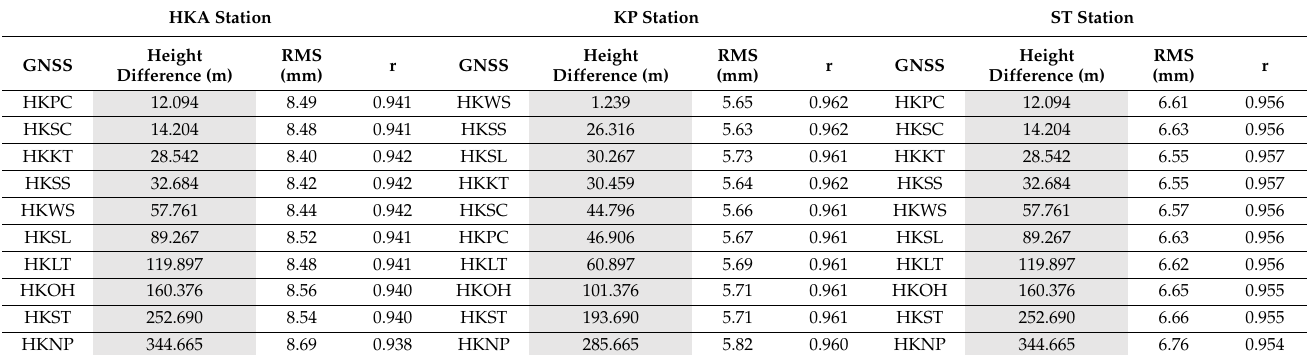
Table 6. Calibration performances of TH-PETs resulting from the temperature, pressure, MJD, and ten sets of ZTD time series at the three weather stations (HKA, KP, and ST) over the period 2008–2019. The height differences between each pair of GNSS/weather stations are